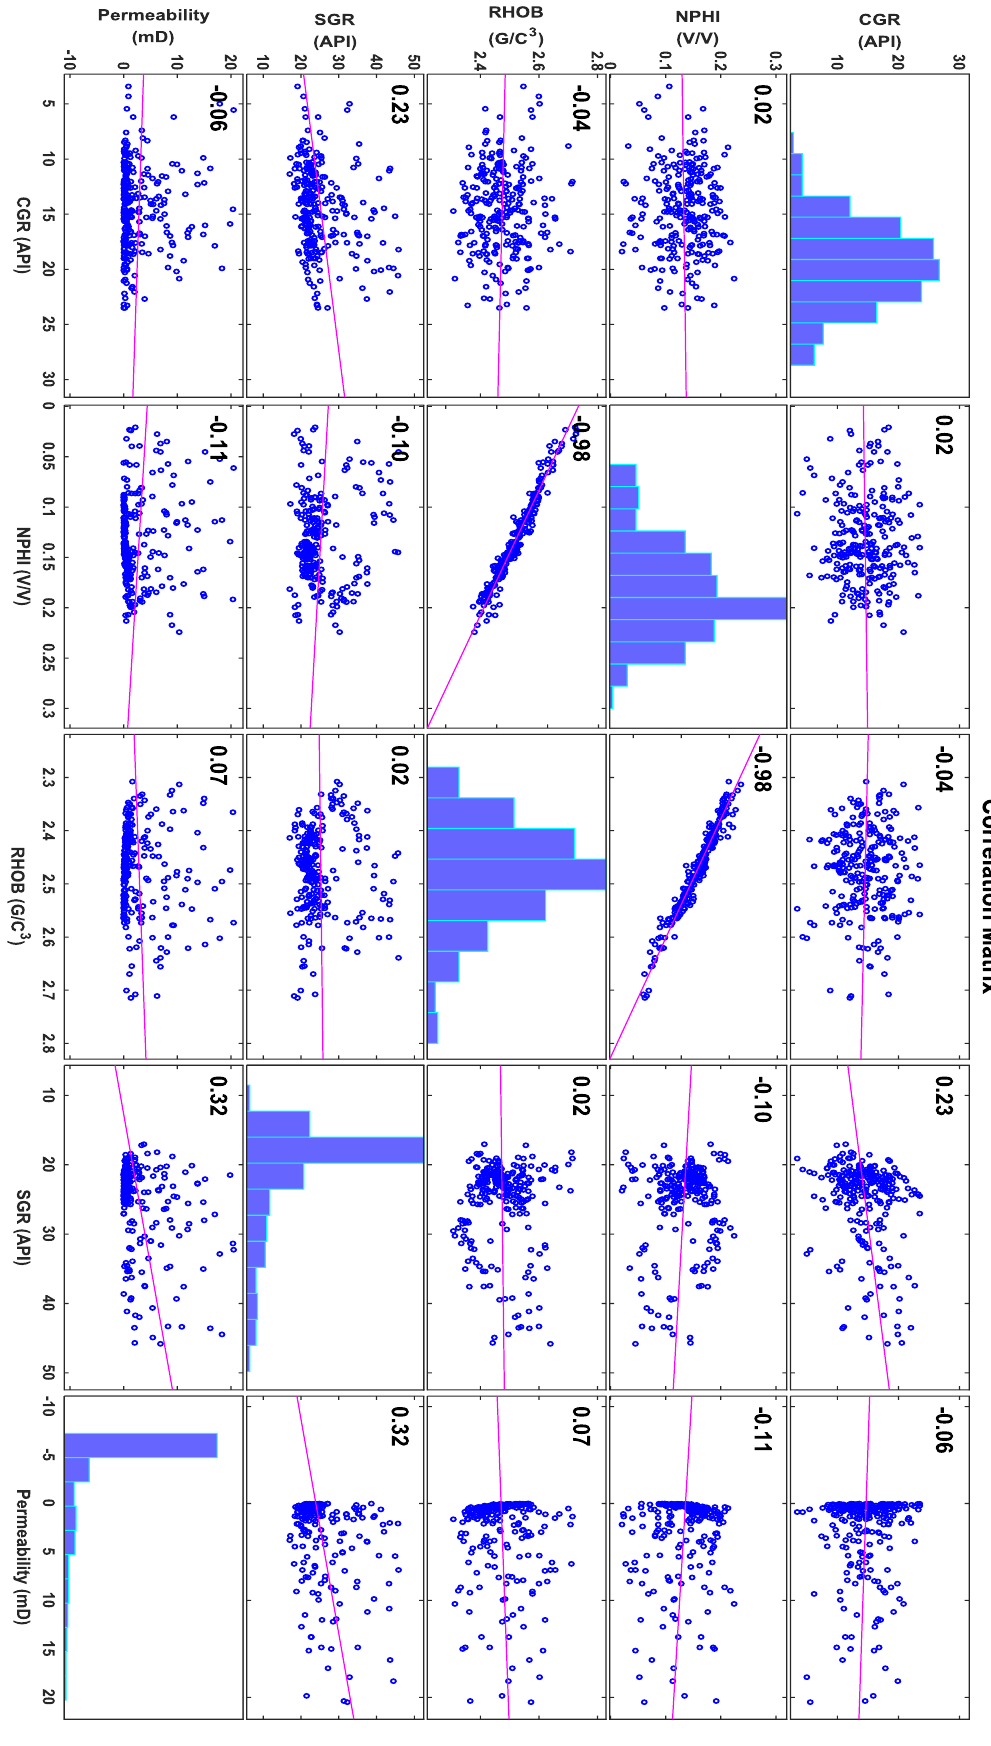
Figure 4. Charts of regression coefficient between selected input and